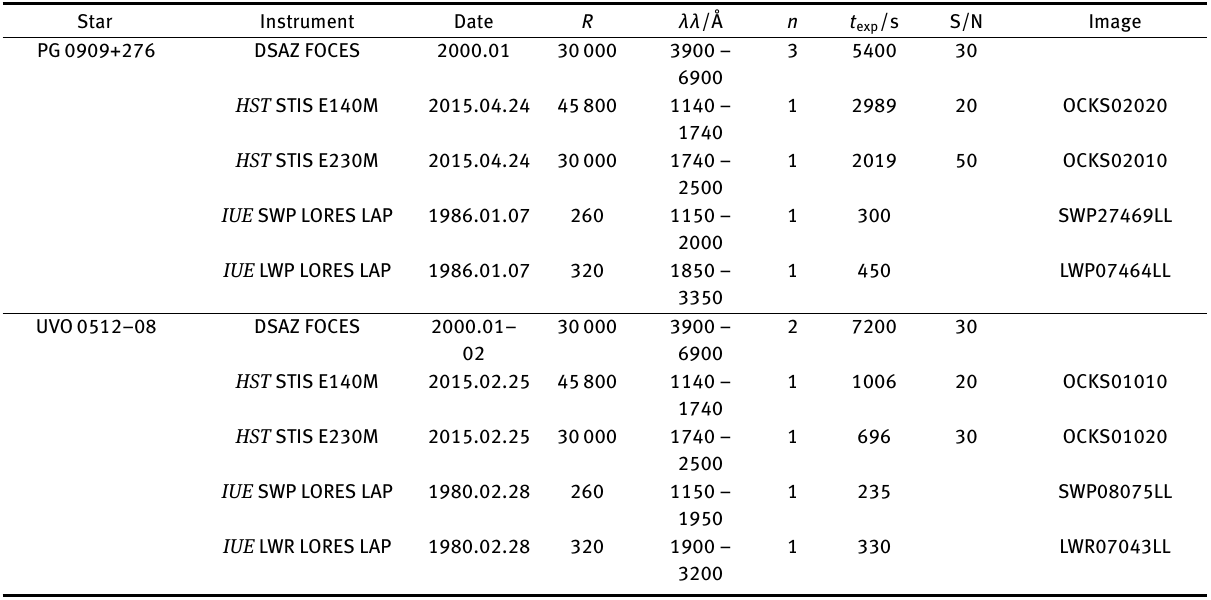
Table 1. Observations used in analysis of PG0909+276 and UVO0512–08 Star